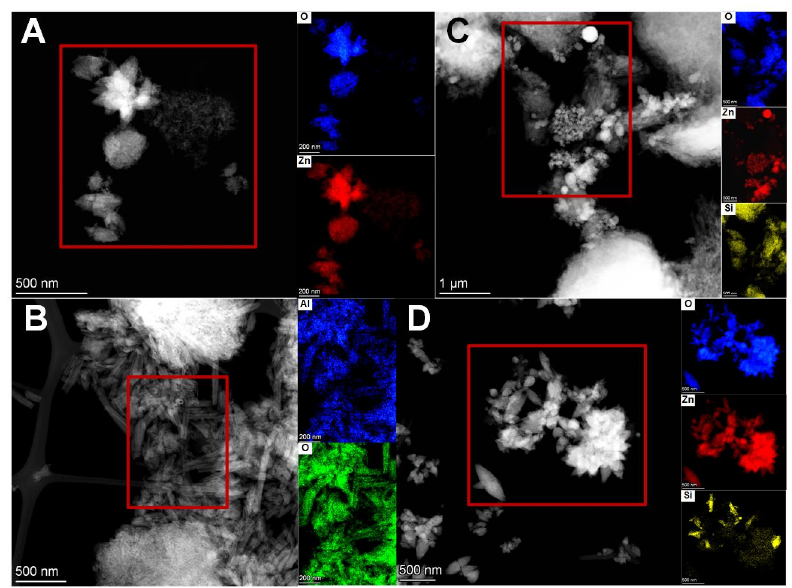
Figure A4. STEM images and EDX elemental composition maps from the designated areas of ( A ): ZnO-100%, ( B ): Hal, ( C ): H-ZnO-5%, ( D ): H-ZnO-28% samples. Table A3. Elemental composition of samples determined by STEM-EDX measurements from the designated areas of Figure A3.